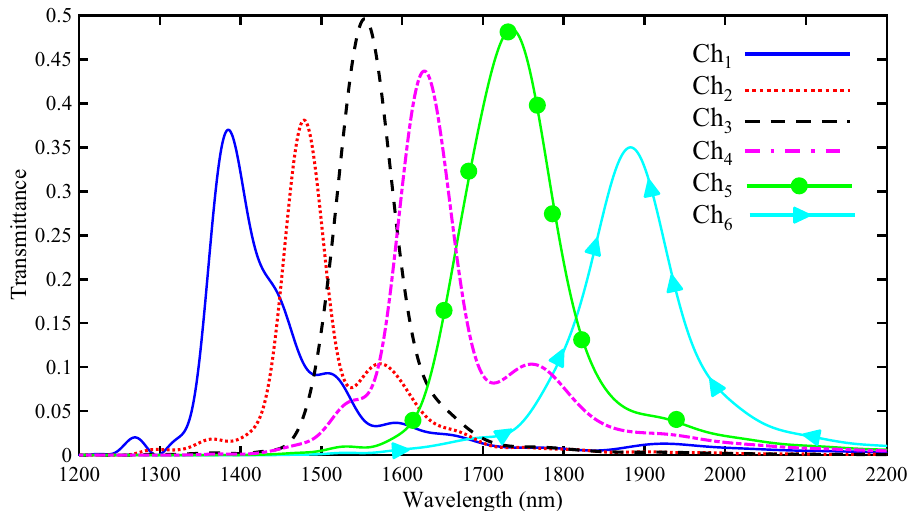
Figure 13. Transmission spectra of the proposed six-channel DEMUX.